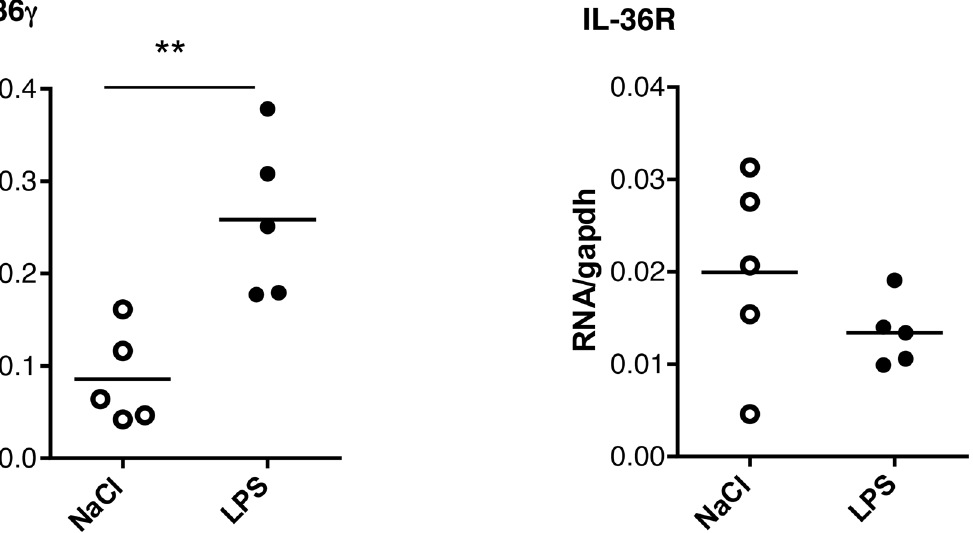
Fig 1. Elevated lung IL-36 γ mRNA levels following LPS instillation. Lung total RNA was extracted 4 h after intra-tracheal instillation of LPS (n = 5 mice) or saline (n = 5 mice). The results represent the levels of Il36g or Il36r mRNA determined by RT-qPCR normalized to Gapdh mRNA. ** P < 0.01, as assessed by Mann-Whitney